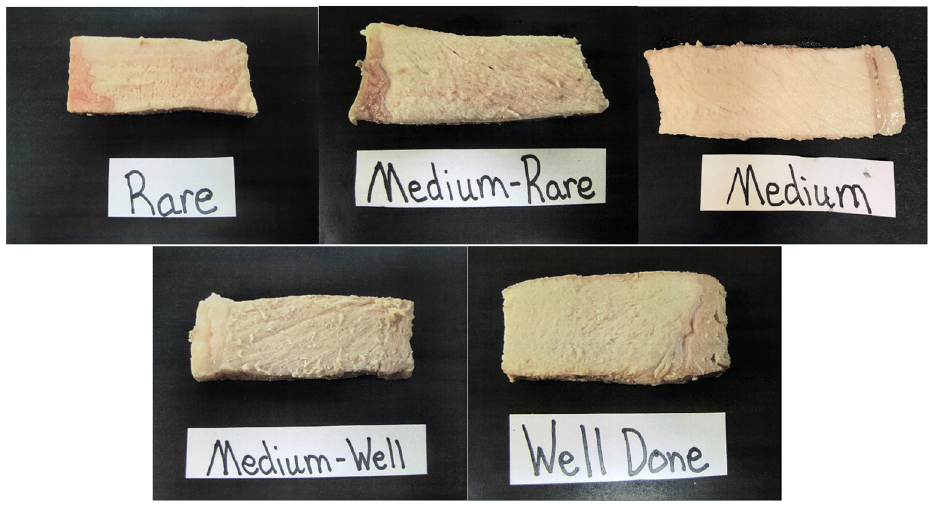
Figure 1. Set of photographs displaying chops cooked to various degrees of doneness used for pre- and post-survey questions. Images display a cooked chop illustrating rare, medium-rare, medium, medium-well, and well done.